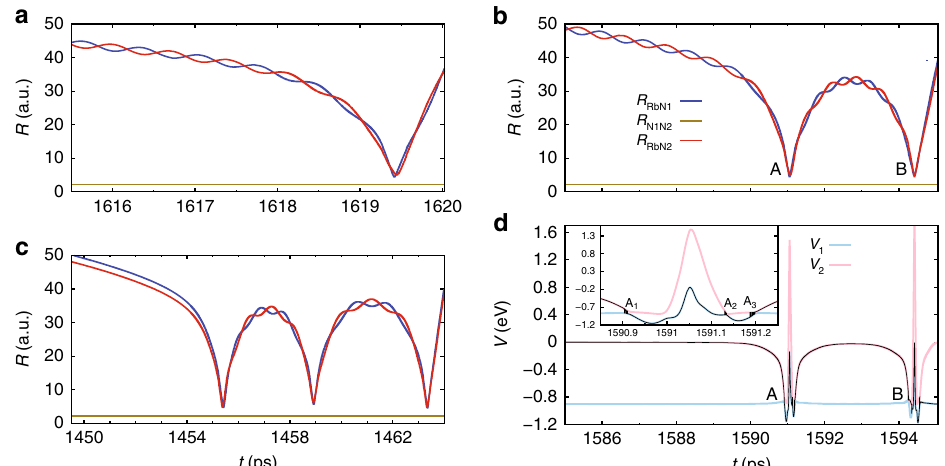
Fig. 7 Direct and indirect CT trajectories. Trajectories are shown in terms of the N 2 – Rb distance R as a function of simulation time t . Panel a represents a direct trajectory while panels b and c show two indirect trajectories with multiple collisions. The trajectory in panel b is further analysed in panel d which shows the change in potential energy with respect to t . The potential energies V 1 and V 2 of the coupled electronic states are shown as faint blue and red lines, respectively. The black line is the energy path of the trajectory. Three hopping regions for the fi rst collision (labelled A 1 – A 3 ) can be seen in the inset. Multiple switchings between the surfaces are observed in the hopping regions.